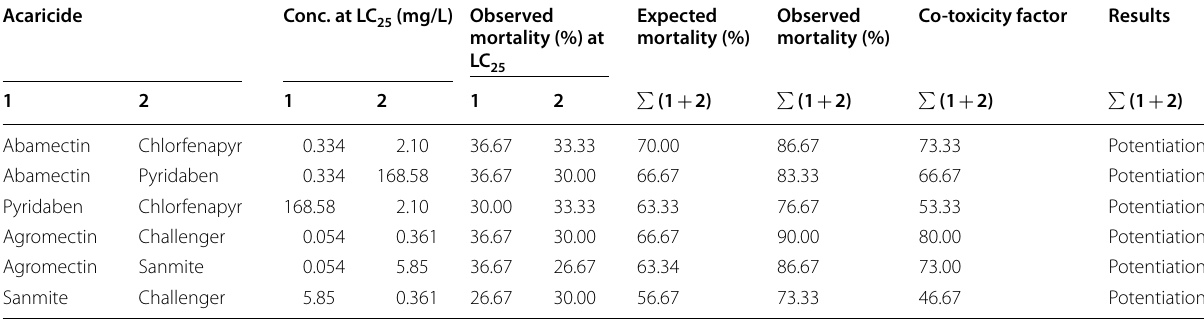
Table 5 Joint toxic effect of technical (abamectin, chlorfenapyr, and pyridaben) and formulated (Agromectin, Challenger, and Sanmite) mixtures at LC values of each acaricide against adult females of T. urticae by slide-dip technique 25